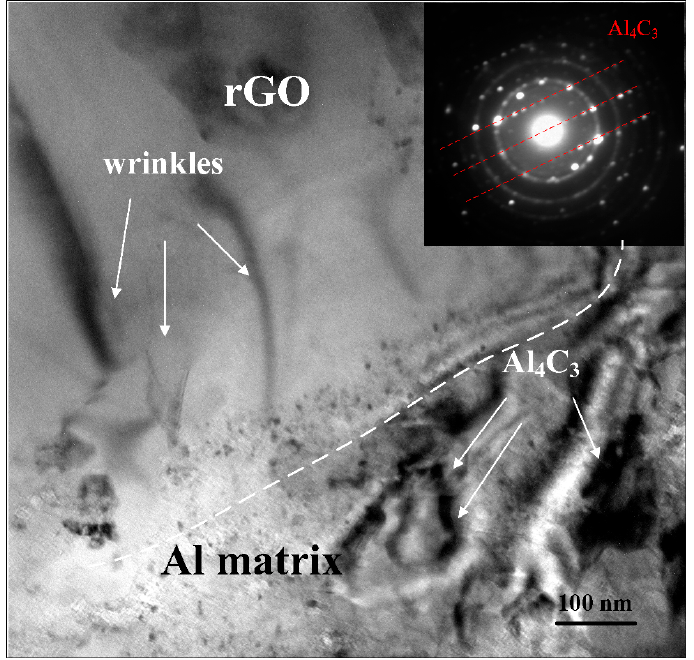
Figure 10. TEM image of 0.30 rGO/7075 Al composite.